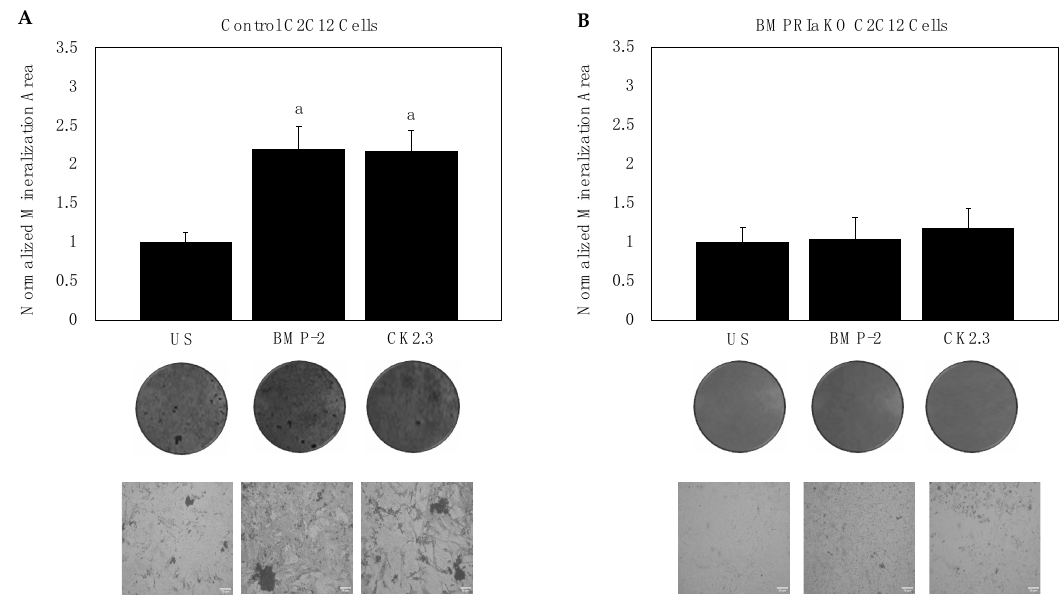
Figure 1. Creation of a BMPRIa Knockout (KO) in the C2C12 cell line. ( A ) In this exon 2 dual guide design, two gRNAs were designed to guide Cas9 to exon 2 within BMPRIa . gRNAs 3 and 5 induced a frameshift deletion of 94 base pairs, causing an abrupt stop downstream in the codon. ( B ) In KO clone 4, BMPRIa contained a 94 base pair deletion between amino acids 38 (asparagine) and 69 (as- paragine). An early stop codon was induced, and DECODR data demonstrated that 100% of the population contained the KO.